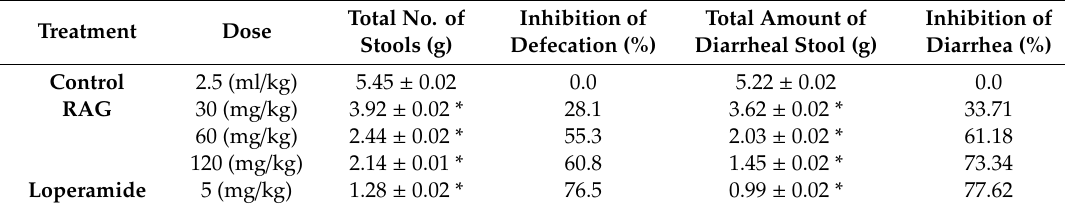
Table 2. E ff ect of red angico gum (RAG, 30–120 mg / kg, p.o.) on castor oil-induced acute diarrhea in mice.